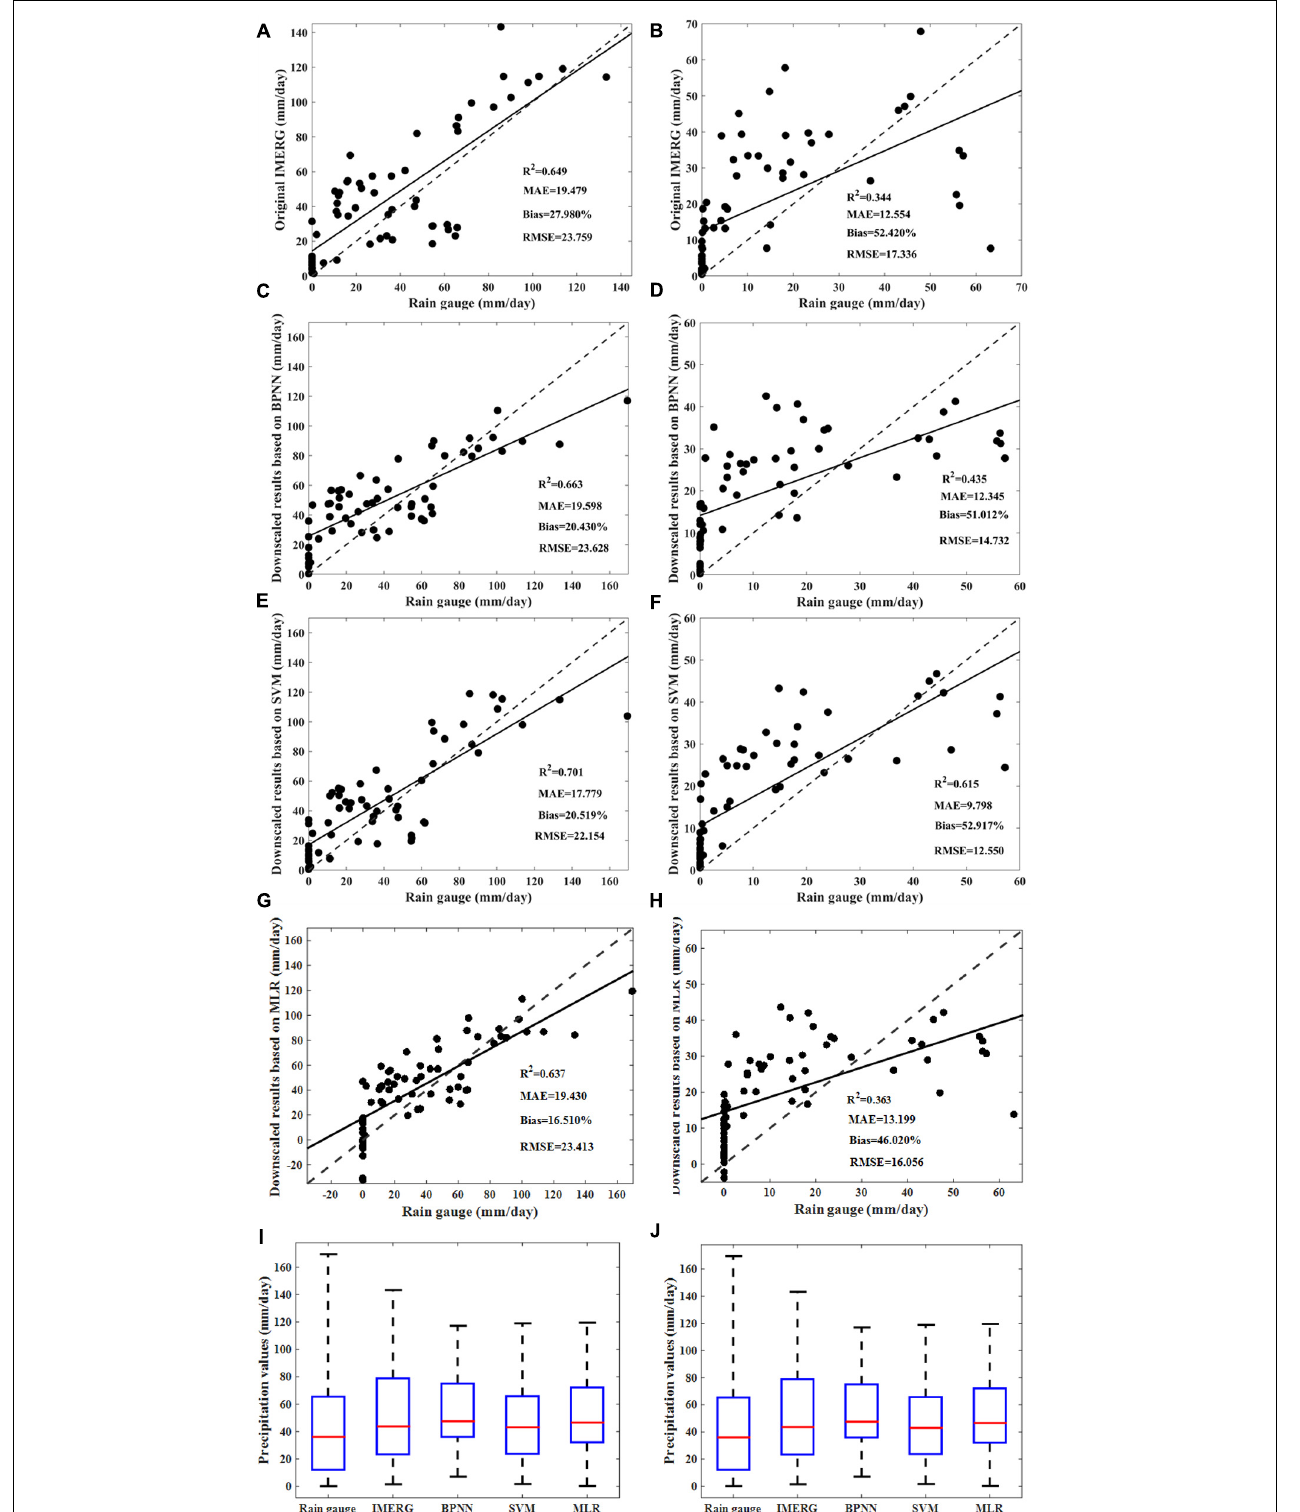
FIGURE 5 | Validations and comparisons of (A,B) the original IMERG in event 1 and event 3, (C,D) downscaled results by BPNN in event 1 and event 3, (E,F) downscaled results by SVM in event 1 and event 3, (G,H) downscaled results by MLR in event 1 and event 3 against ground observations, and (I,J) boxplots of the five precipitation datasets in event 1 and event 3 over Zhejiang